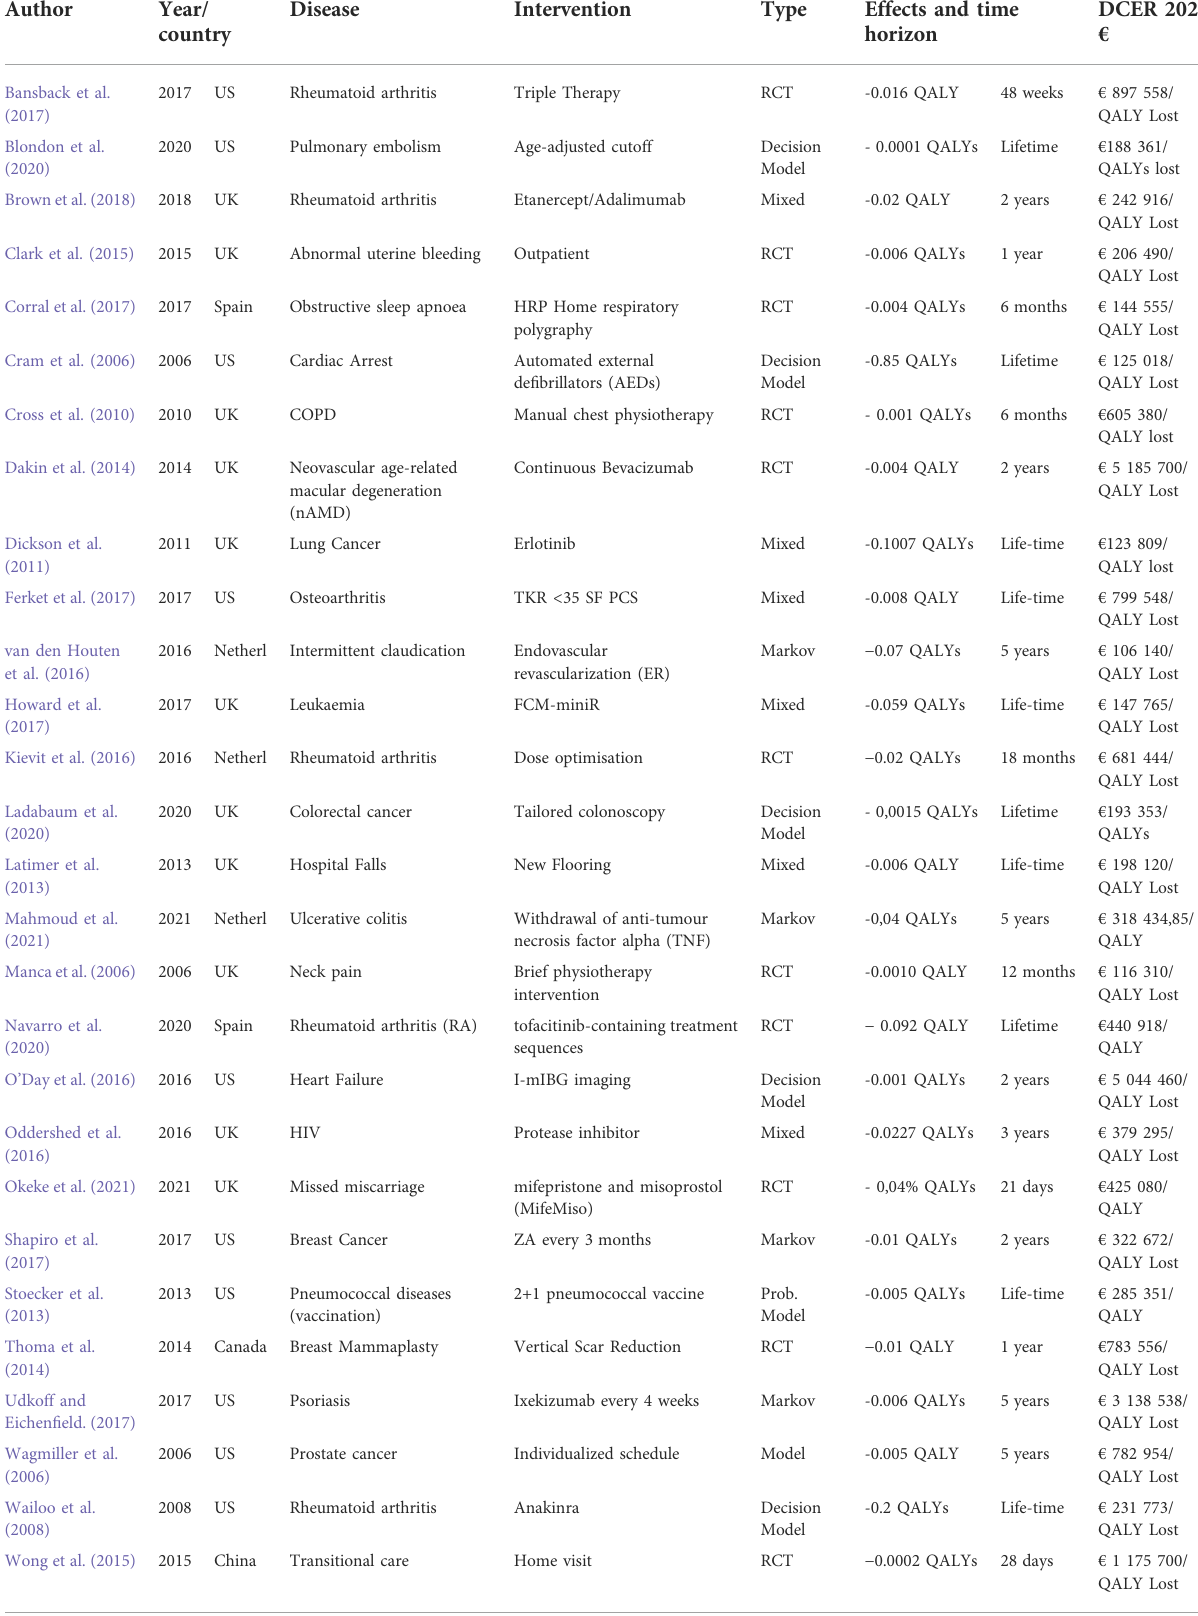
TABLE 1 Key characteristics of studies with a point estimate of the cost utility ratio greater than € 100,000/Qaly